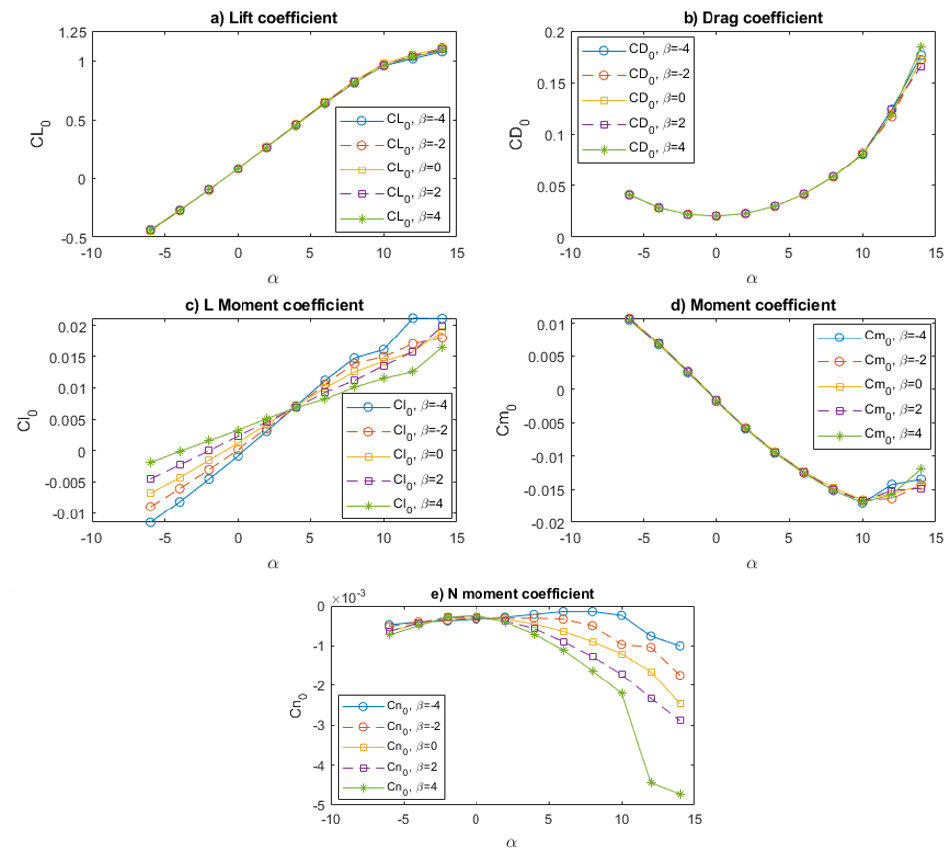
Figure 19. Effects of changes in angle of attack and angle of slip on the force coefficients and moment coefficients: ( a ) lift coefficient, ( b ) drag coefficient, ( c ) L moment coefficient, ( d ) M moment coefficient, ( e ) N moment